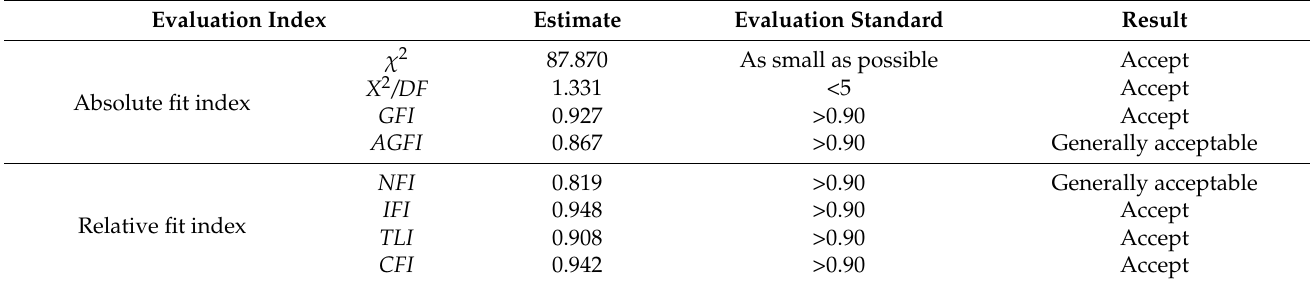
Table 6. Test results for the degree of model